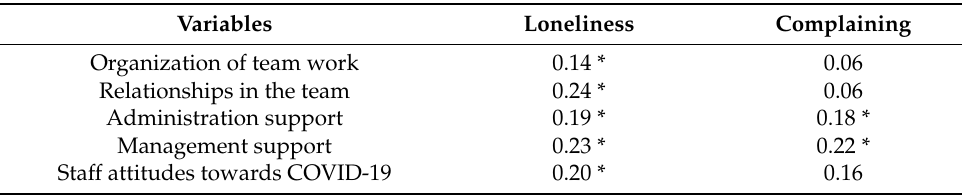
Table 4. Correlations between loneliness and complaining and organizational and interpersonal variables related to the syndrome (Pearson’s correlation coefficient). Variables Loneliness Complaining Organization of team work 0.14 * 0.06 Relationships in the team 0.24 * 0.06 Administration support 0.19 * 0.18 * Management support 0.23 * 0.22 * Staff attitudes towards COVID-19 0.20 *